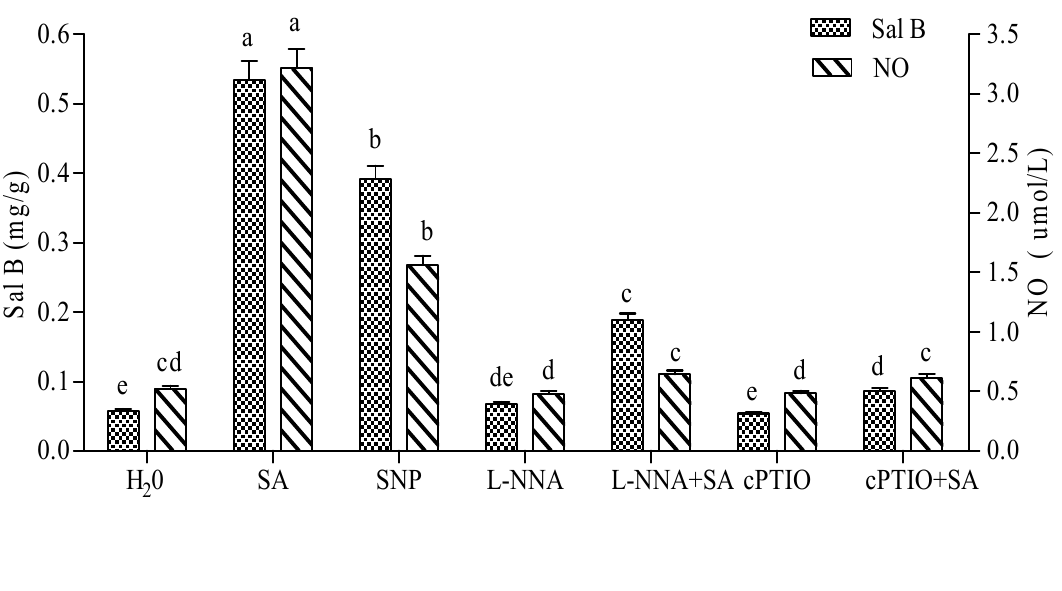
Figure 2. Effects of SA, sodium nitroprusside (SNP), N ω -nitro- L -arginine (L-NNA), carboxy-2-phenyl-4,4,5,5-tetramethylimidazoline-1-oxyl-3-oxide (cPTIO) and